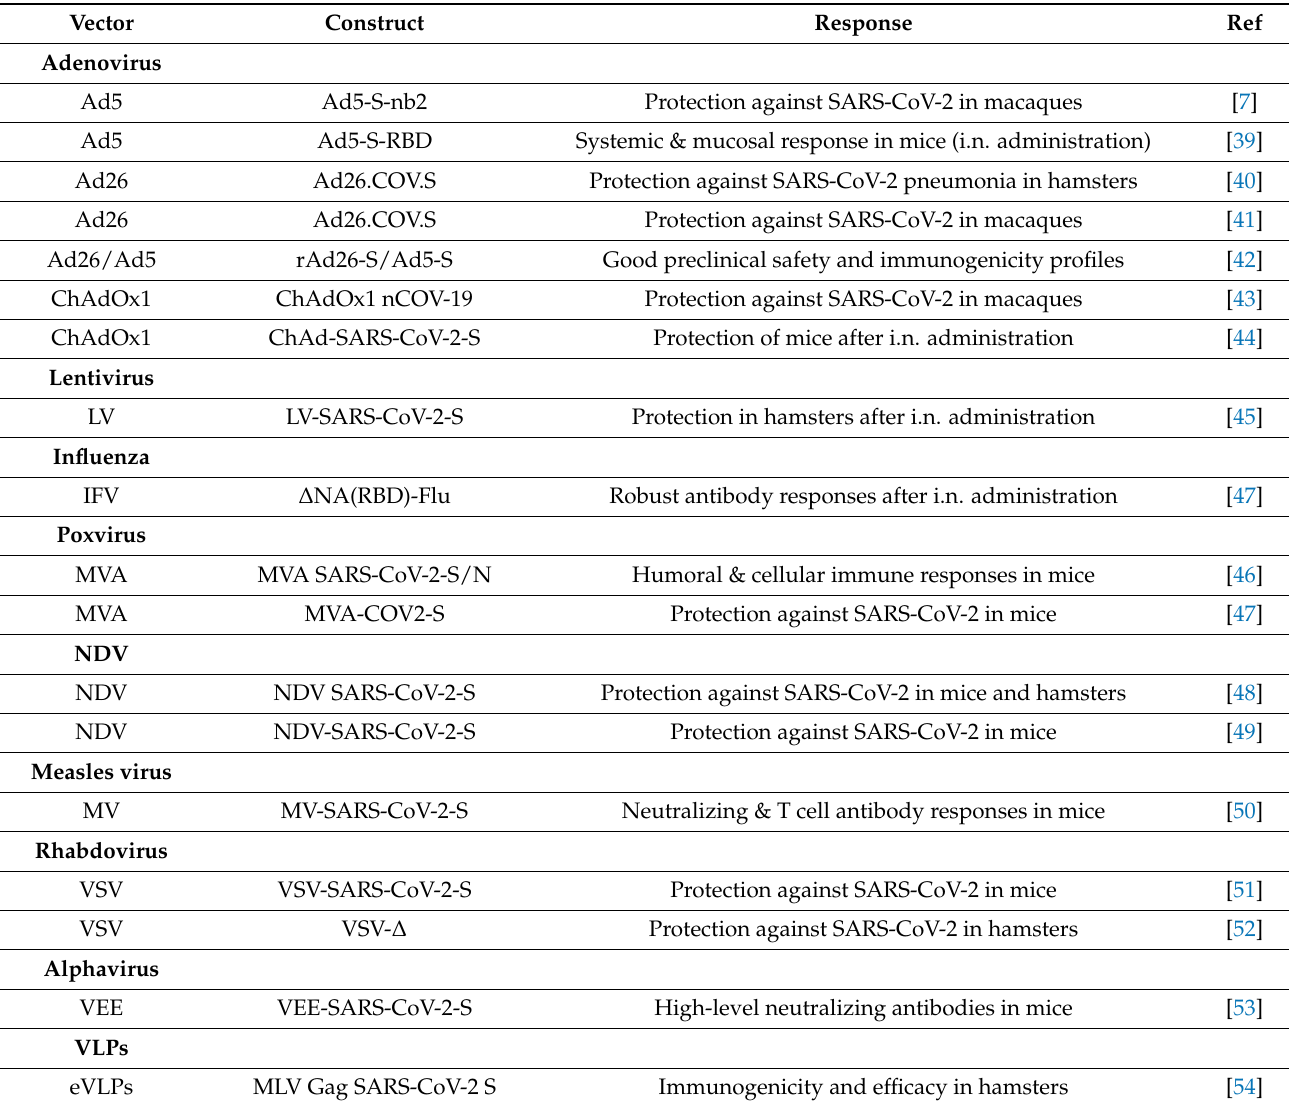
Table 1. Examples of preclinical studies for viral vector-based SARS-CoV-2 vaccine